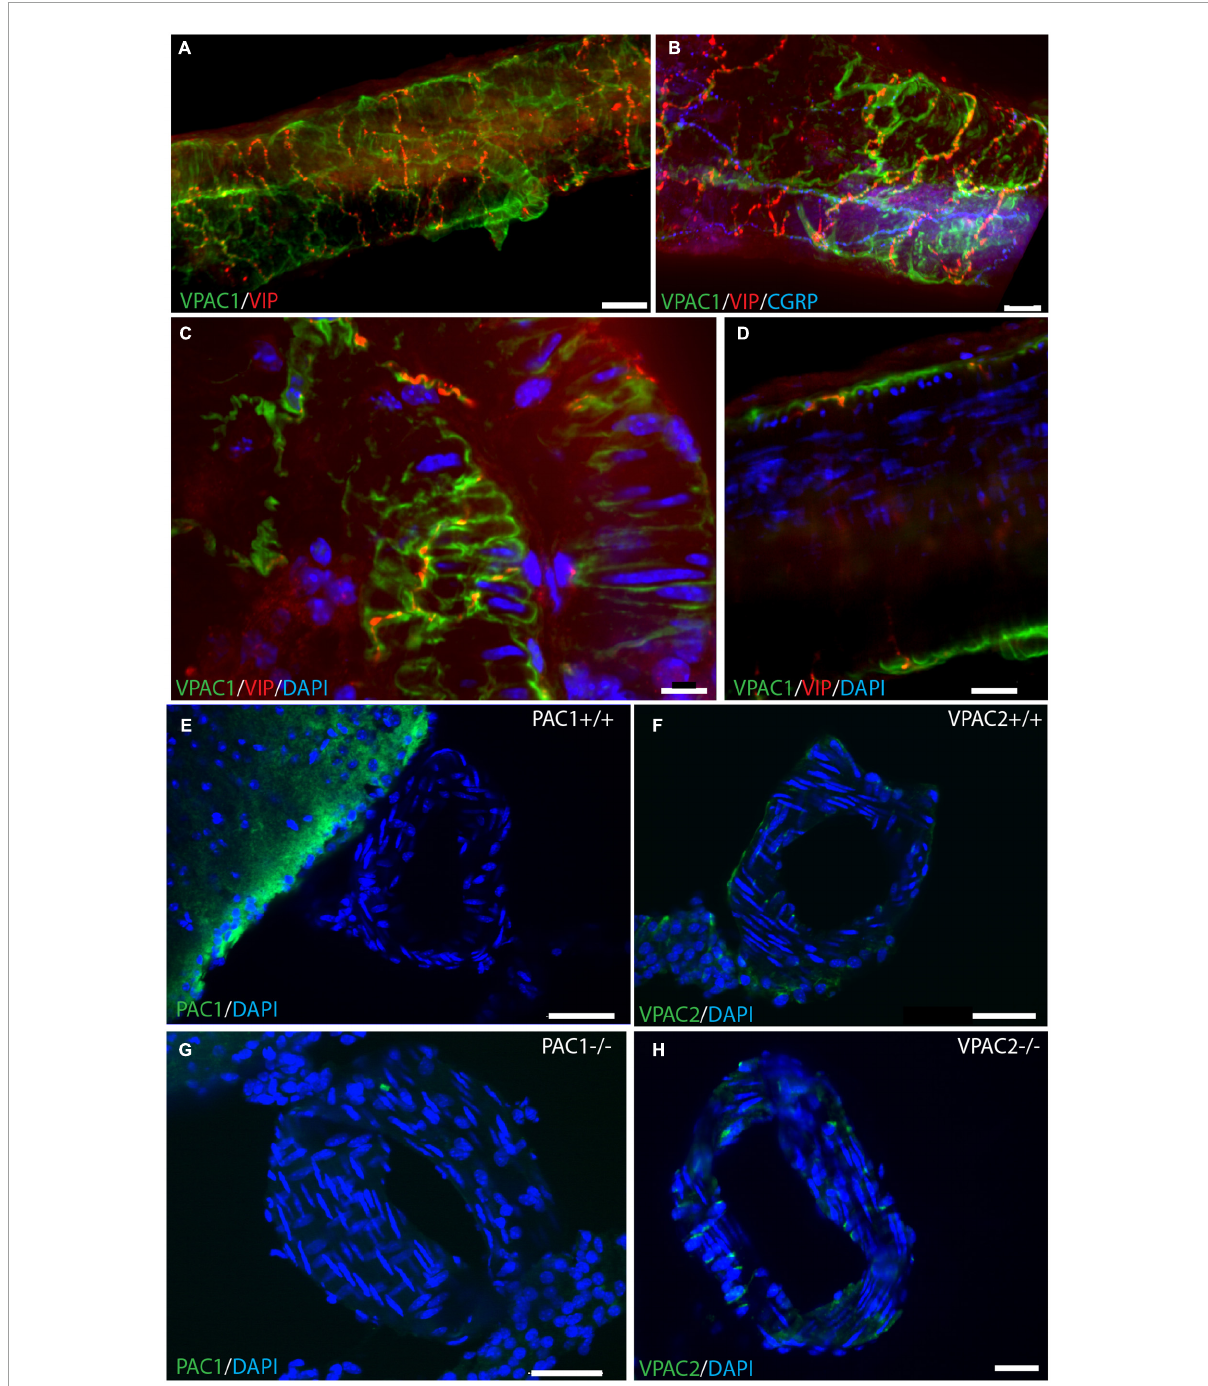
FIGURE2 VPAC1 receptor immunoreactivity in whole mount preparation of a cerebral artery. Double immunostaining of the VPAC1 receptor (green) and VIP (red) in panel (A) and triple immunostaining of the same artery in panel (B) with CGRP (blue). Note that the two neuropeptides have different distribution patterns. Higher magnification illustrates VPAC1 immunostaining on the surface of smooth muscle cells innervated by VIP-containing nerve fibers (C,D) . VIP immunoreactive nerve fibers with close contact to the VPAC1 receptor on the plasmalemma of cross-sectioned smooth muscle cells in panel (C) . Cross section of a basal artery of wild type mouse close to a. cerebri ant. shows no expression of the PAC1 receptor (green) (E,G) or the VPAC2 receptor (green) (F,H) . Note that in PAC1 (G) —and in VPAC2 (H) deficient mice no specific staining can be demonstrated as also found in both wild type mice [PAC1 in panel (E) and VPAC2 in panel (F) ]. Panels (A,B) represent a 3D reconstruction of a Z-stack [ (A) : Z = 0.5 µ m, (B) : Z = 0.3 µ m] of 152 digital sections. Scale bars (A,B) = 20 µ m, (C) = 10 µ m, (D) = 20 µ m, (E–H) = 30 µ